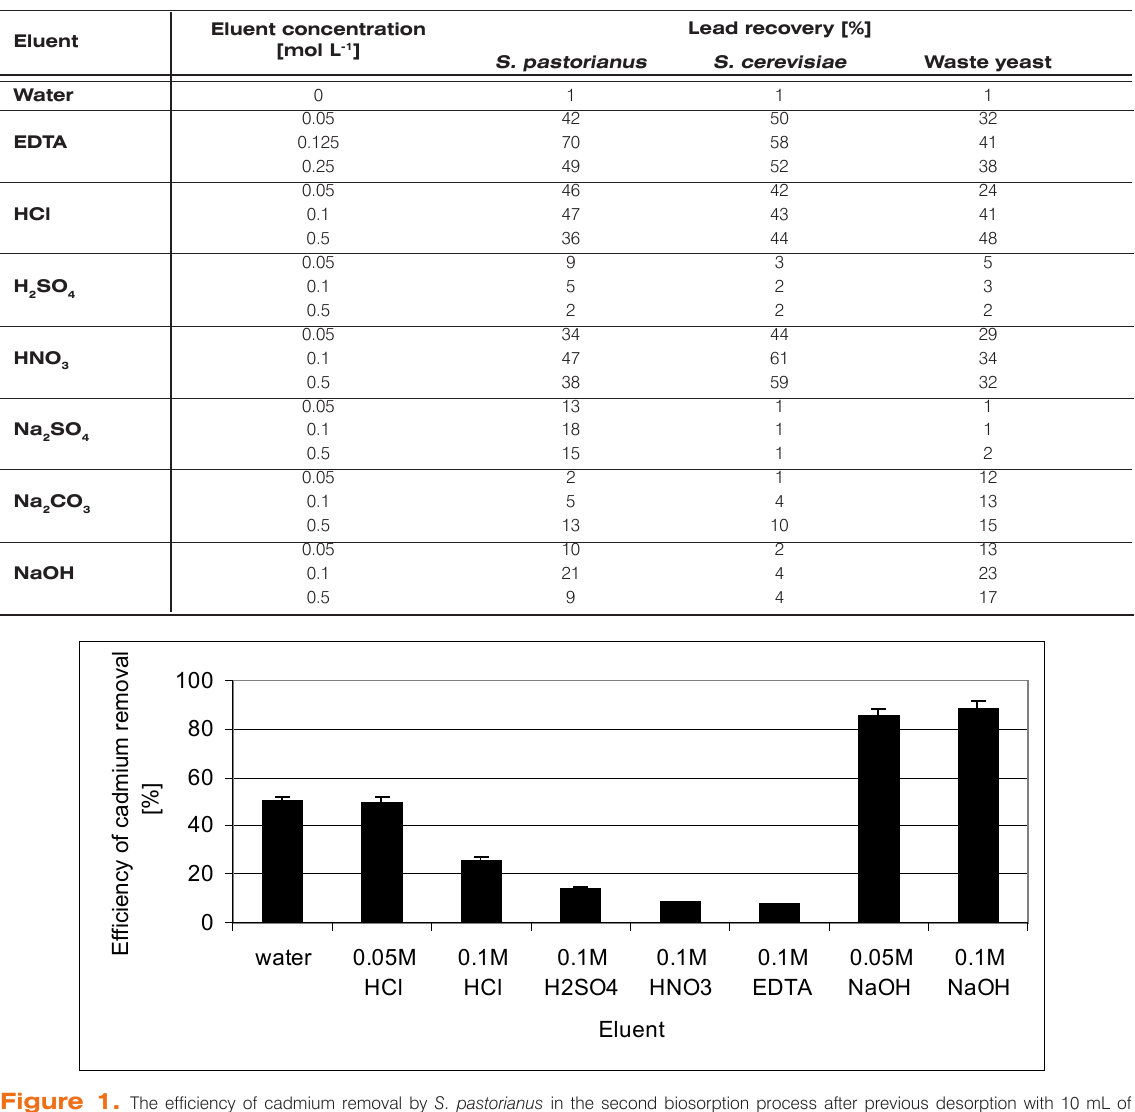
Table 5. The lead desorption efficiency of 5 mL of various eluents (liquid to solid ratio of 0.01 L g -1 ).